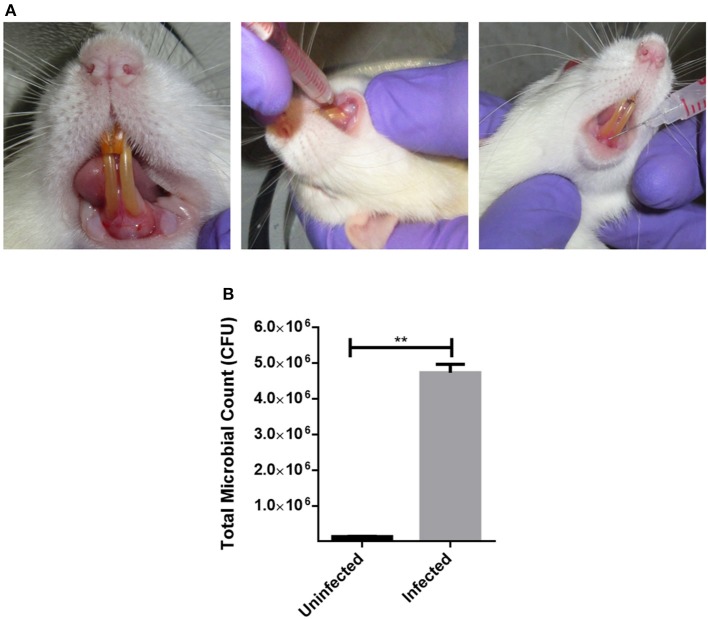
Establishing a humanized model of periodontitis in rats. (A) Sprague Dawley rats were injected with pooled plaque samples from 5 chronic periodontitis patients. To establish a humanozed model of periodontitis, they were incubated for 21 days with normal food and water. (B) Post-incubation, the total CFU from the site of infection was ennumerated to confirm the disease establishment. **P < 0.005.